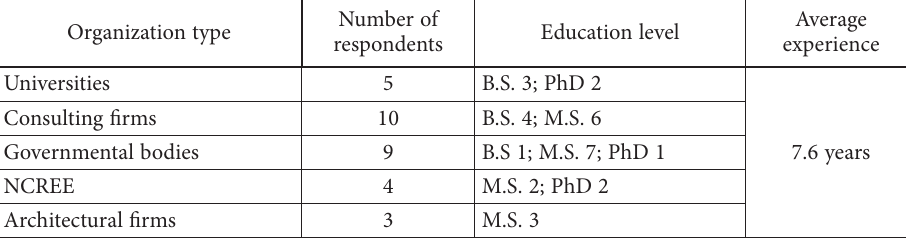
Table 2. Characteristics of respondents to the expert survey